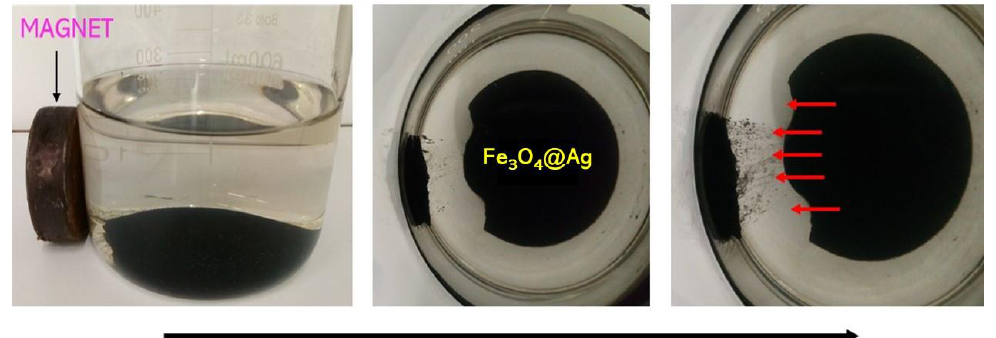
Figure 5. Magnetic properties of the obtained Fe 3 O 4 @Ag particles.